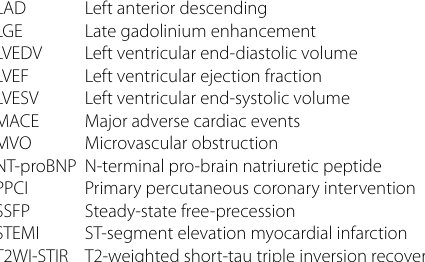
0.037). b Native T1 1w > 1261 ms